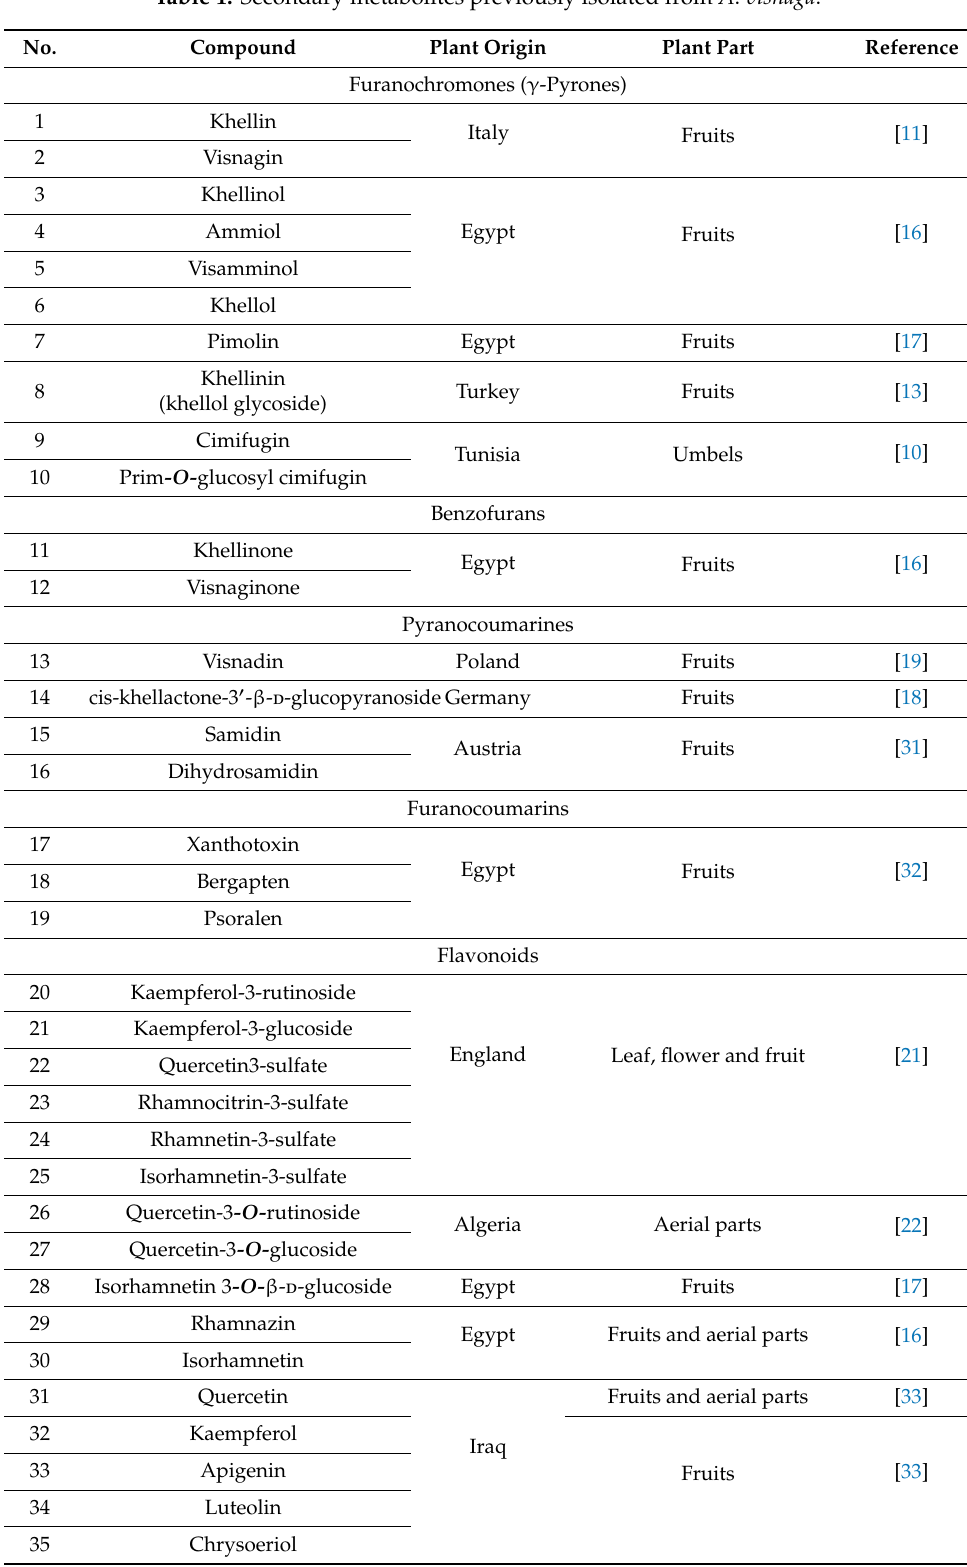
Table 1. Secondary metabolites previously isolated from A . visnaga